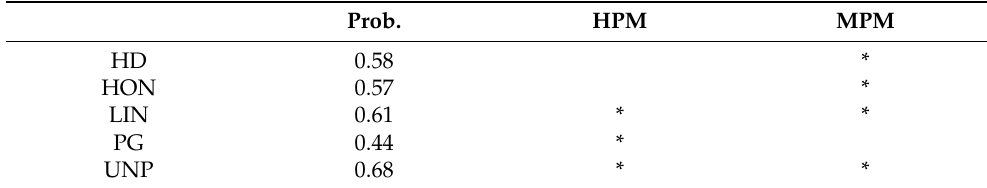
Table 3. Bayesian Variable Selection: WTI price as a dependent variable. Prob.